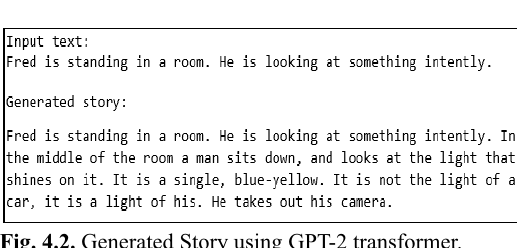
Fig. 4.2. Generated Story using GPT-2 transformer.